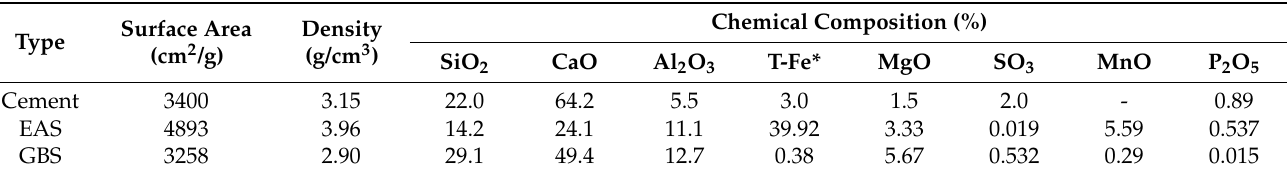
Table 2. Chemical and physical properties of cementitious